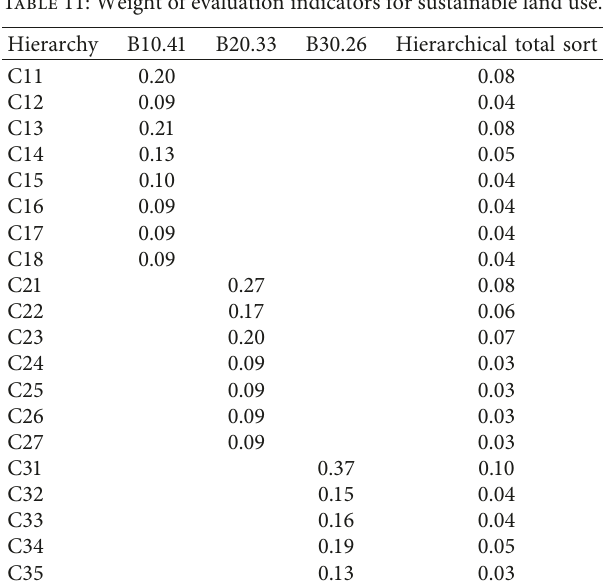
Table 11: Weight of evaluation indicators for sustainable land use. Hierarchy